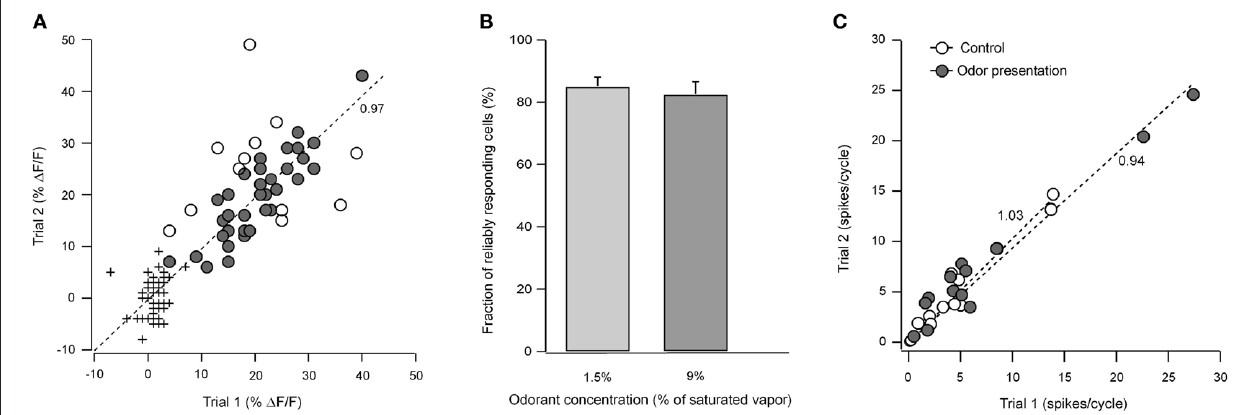
FIGURE A1 | Consistency of odorant-evoked responses in repeated trials. (A) Amplitudes of odor-evoked neuronal Ca 2 + transients recorded in two different trials (circles) plotted against each other. The crosses depict the noise level in the corresponding traces. Dark circles mark cells whose response amplitudes changed by an amount smaller than two standard deviations of the noise level (reliably responding cells), the open circles mark cells with a larger variation in response amplitude. The odorant was 2-hexanone at 9% of saturated vapor. The dashed line represents the linear least-squares fit of the data. (B) Fraction of reliably responding cells at two different odorant concentrations ( n = 88 cells, 5 experiments and n = 201 cells, 8 experiments for 1.5, and 9% of